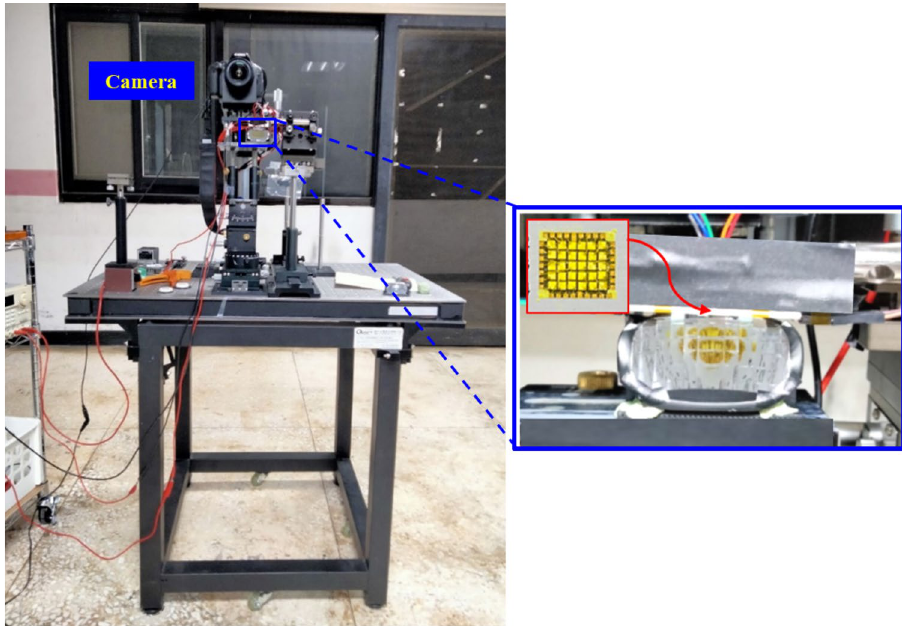
Figure 7. The head lamp module on the test platform in the